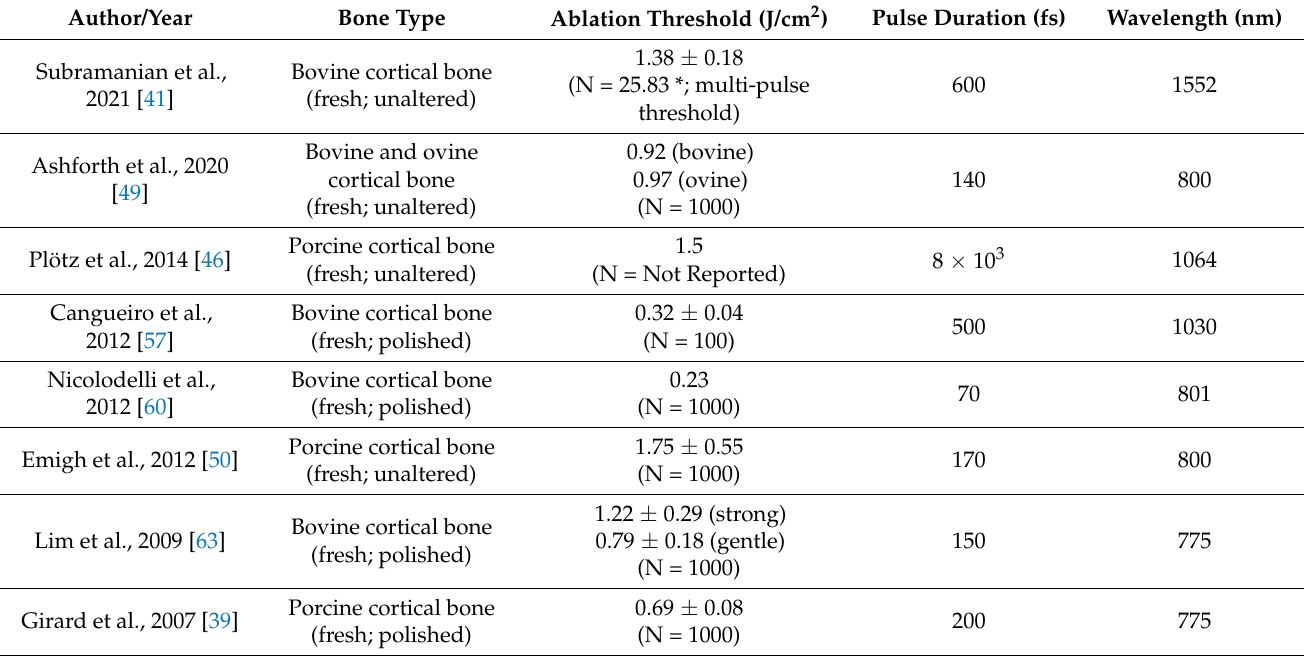
Table 3. Summary of ablation thresholds determined for different bone types. N = Number of